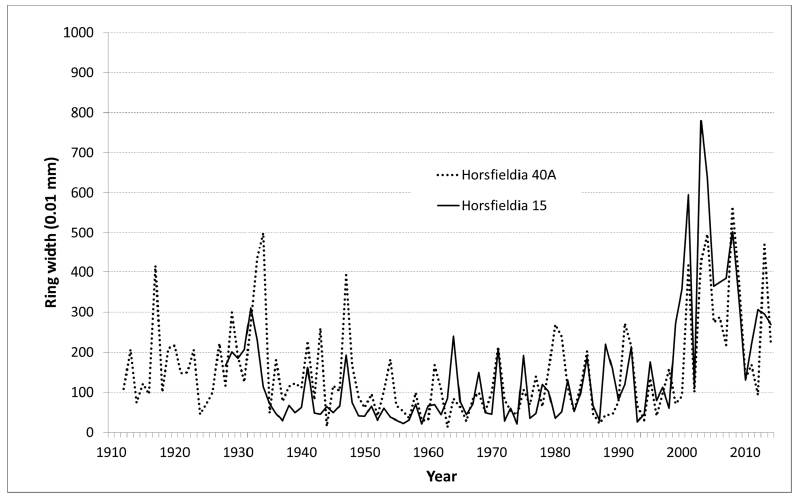
Figure 6. Ring width curves of two samples from Horsfieldia crassifolia from a peat swamp forest near Terantang Hilir, Kalimantan, Indonesia. Note the sudden release after the year 2000 in both curves, likely as a result of nearby logging activities. Table 3. Results of cross dating (comparison) between different time series expressed as % parallel run between two curves respectively.